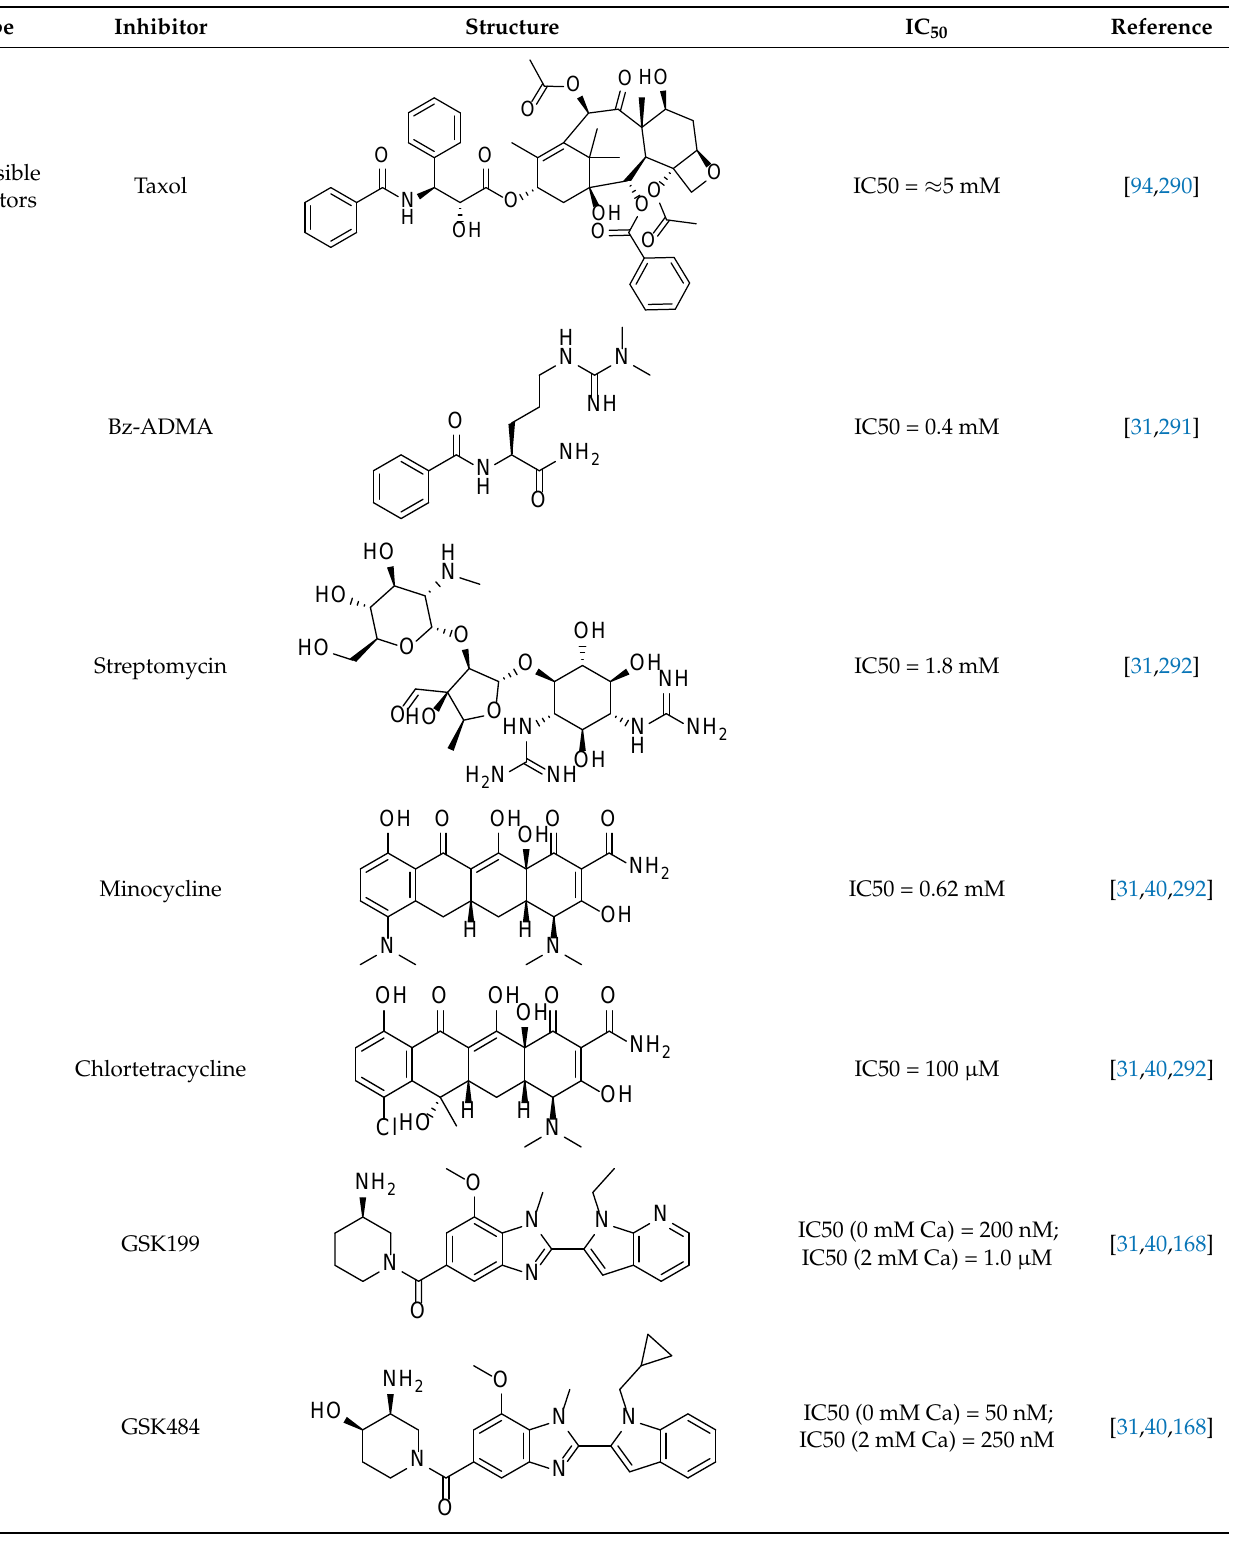
Table 3. An overview of PAD4 Table 3. An overview of PAD4 inhibitors. Table 3. An overview of PAD4 inhibitors. Table 3. An overview of PAD4 inhibitors. Table 3. An overview of PAD4 inhibitors.